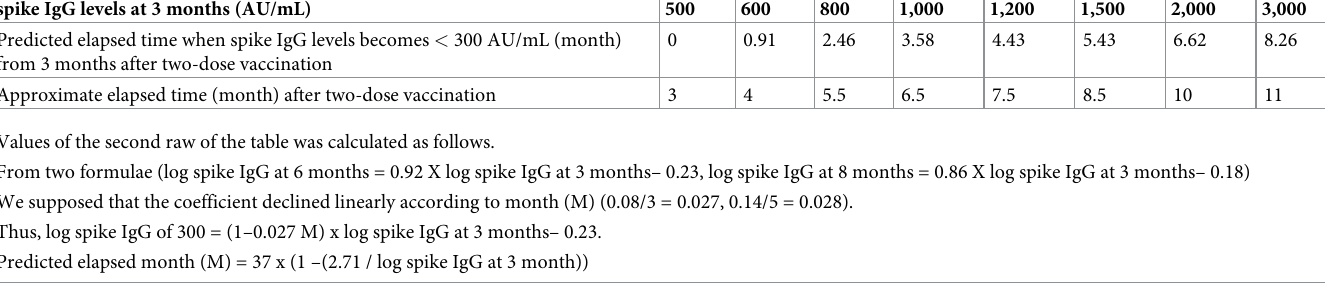
Table 5. Estimated elapsed time when spike IgG level declines below 300 AU/Ml. spike IgG levels at 3 months